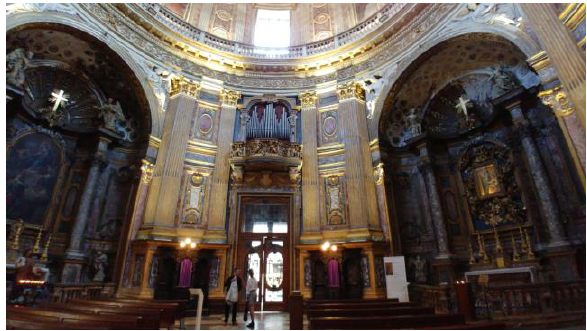
Figure 1. Interna part of the Church of the Santissima Trinità. On the side of the main altar of the Church, there are two symmetrical doors (Figure 2), richly decorated, that provide the access to the service areas. In particular, the one on the left side is the reference (Figure 3a), while the one on the right has the missing elements (Figure 3b).